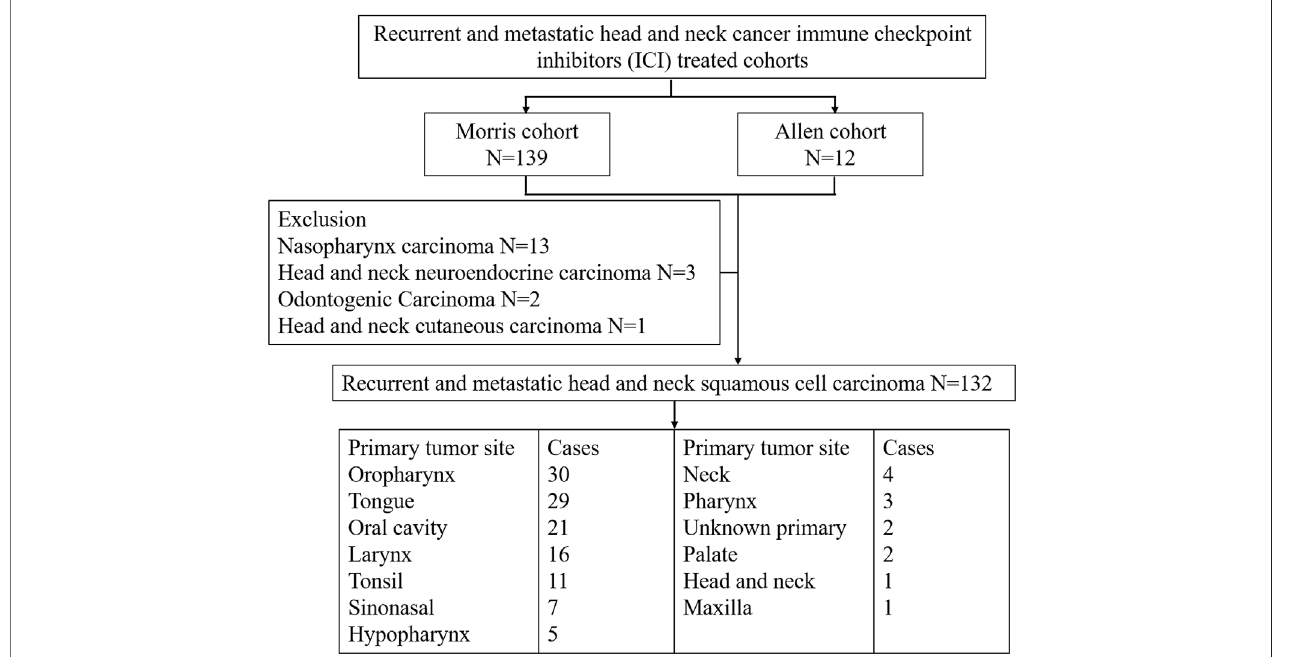
FIGURE 1 | Patient selection of recurrent and metastatic head and neck cancer immune checkpoint inhibitor (ICI)-treated cohorts.